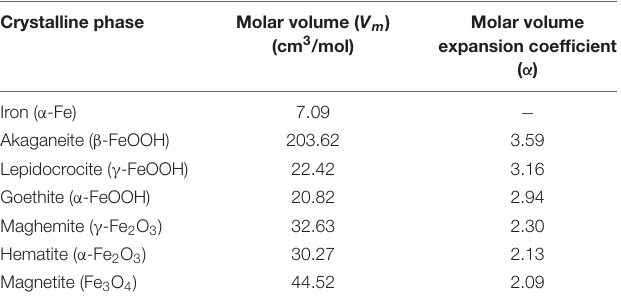
TABLE 1 | Molar volume ( V m ) and molar volume expansion coefficient ( α ) ( α = V m ( oxyhydroxide ) / V m ( Fe ) ) for iron oxyhydroxides (Sánchez-Deza et al., 2017, 2018).